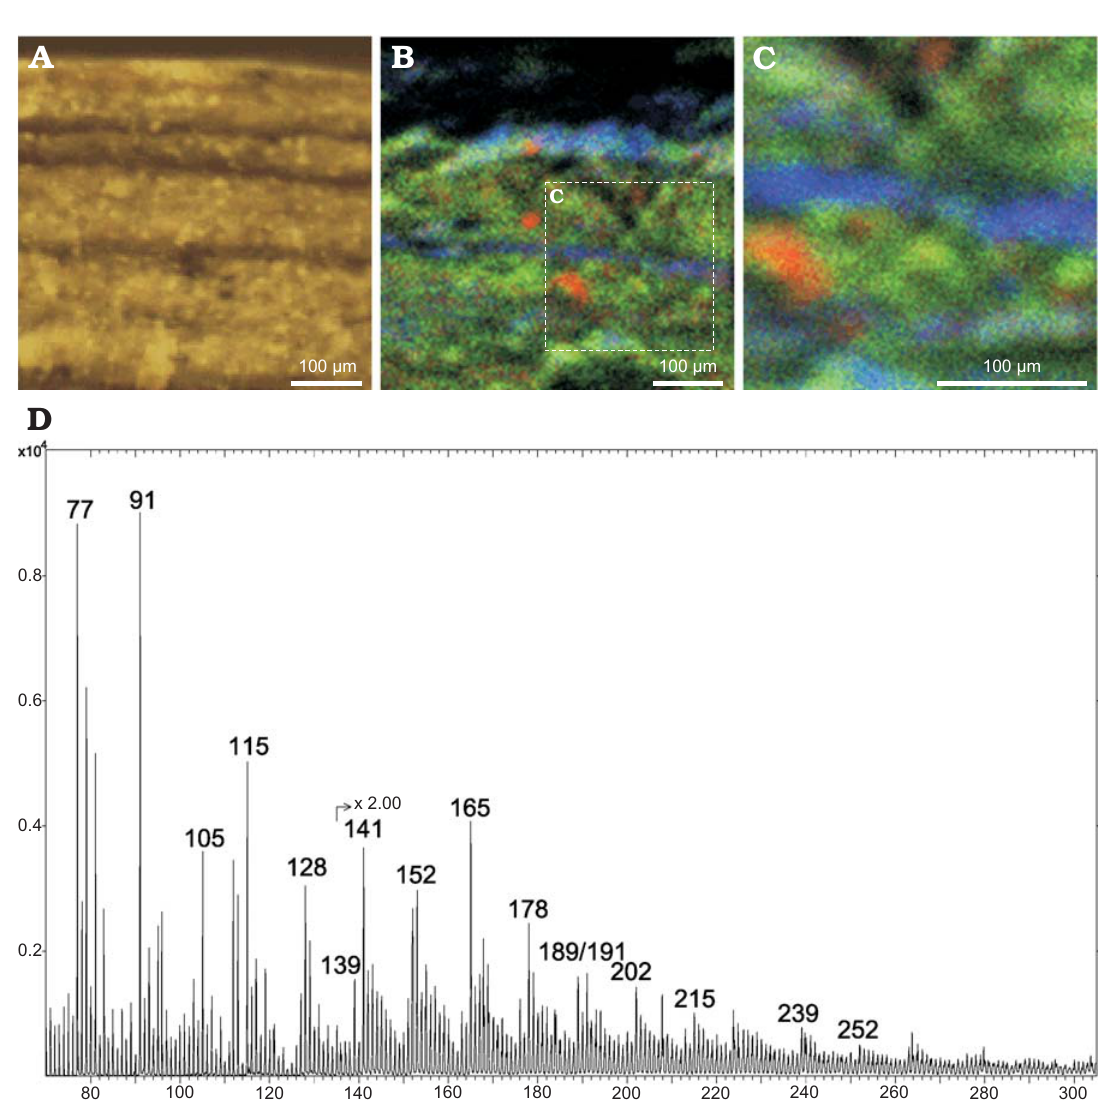
Fig. 8. ToF-SIMS ion images and spectrum of an oil shale rhythmite (USNM 593433) from the Coal Creek member of the Kishenehn Formation, Eocene, Montana, USA. A . Micrograph of shale. B . Composite ion image with silica (green), calcium (red), and combined polyaromatic hydrocarbons (blue) imaged. C . Ion image of the polyaromatic hydrocarbon rich microbial mat layer. D . Positive ToF-SIMS spectrum of blue area in C. Numbers indicate aro- matics at m/z 77.04 (C H ), 91.05 (C H ), 105.09 (C H ), 115.05 (C H ), 128.05 (C H ), 141.06 (C H ), 152.05 (C H ), 165.06 (C H ), 178.06 (C H ), 6 5 7 7 8 9 9 7 10 8 11 9 12 8 13 9 14 10 189.05 (C H ), 202.06 (C H ), 215.07 (C H ), 239.05 (C H 15 9 16 10 17 11 19 11